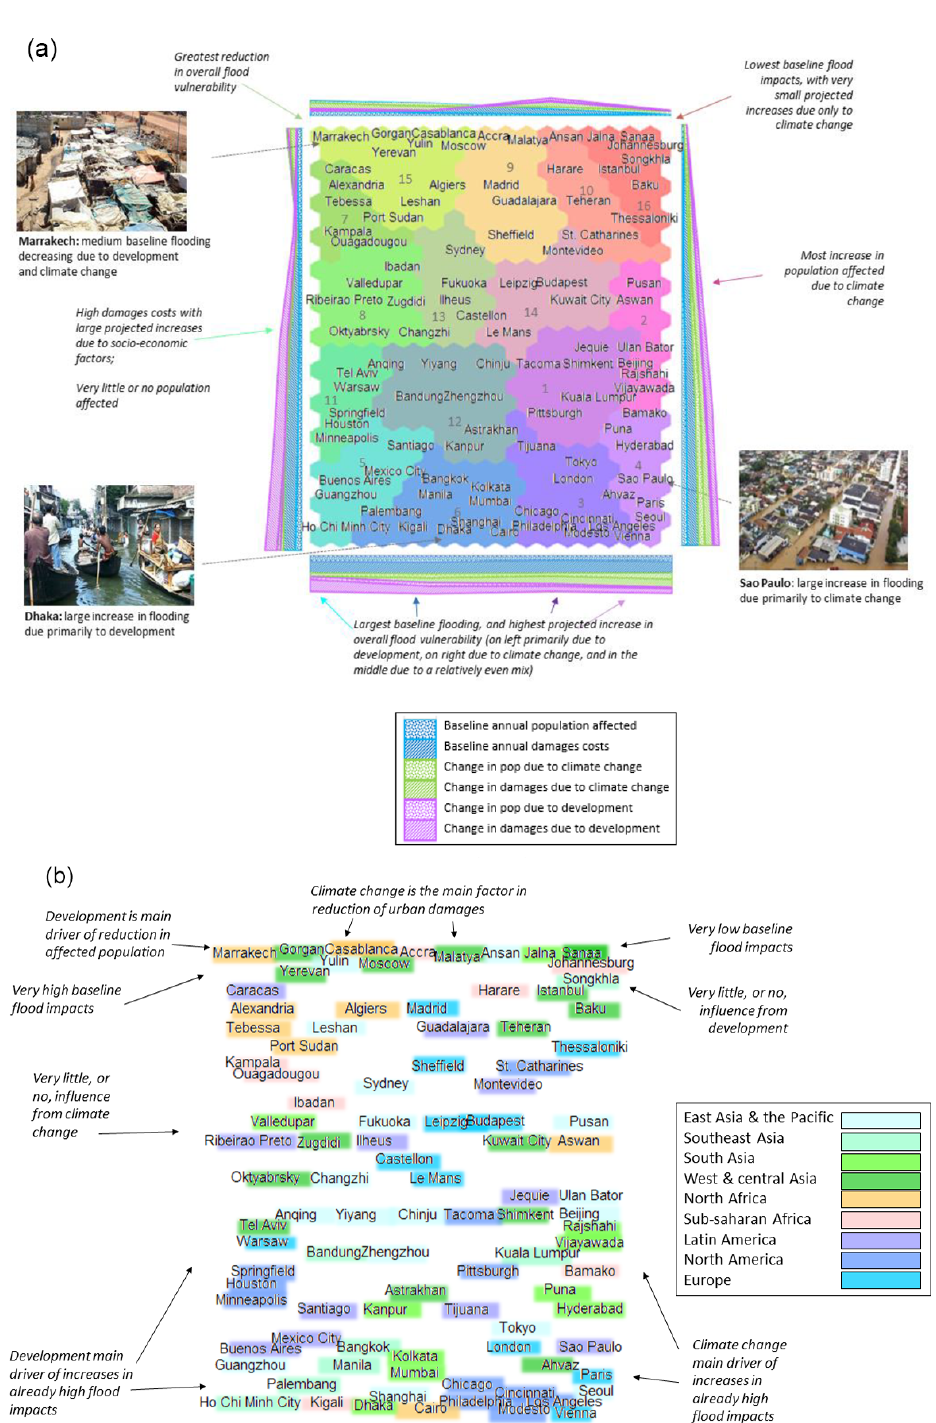
Figure 3. SOM3 – temporal patterns – cities are clustered close together that share similar baseline (2010) flood vulnerabilities as well as similar anticipated changes driven by climate change and development on population and urban damage costs by 2030. (a) Locations of the cities are based on their individual relationships to the principal curves in the baseline and future projected changes data subsets. therefore, the axes represent the most important nonlinear gradients of flood vulnerabilities in the data set. Coloured bars along the axes indicate the average levels of each variable around the edges of the map. Cities are grouped into coloured clusters based on similarities. (b) City labels are coloured by region, and characteristic patterns of general areas of the map are annotated. The reader may refer to the online version to zoom in on text if